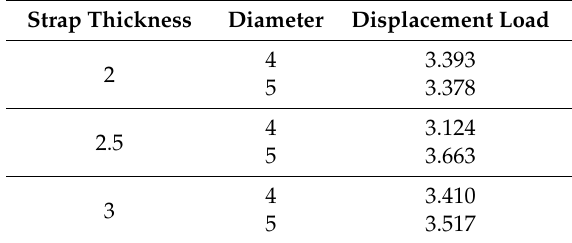
Table 4. Displacement loads for different strap thicknesses and rivets (unit: mm).